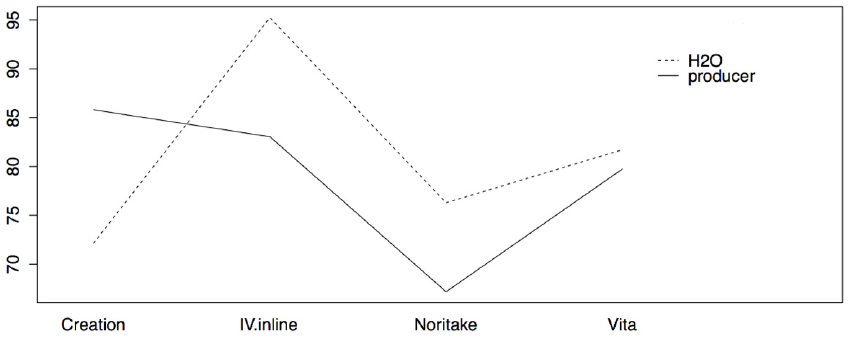
Figure 2. Mean of MPA interaction of the various tested ceramic groups CR, IV, NR, and VT, mixed with H 2 O or their corresponding modeling liquids.